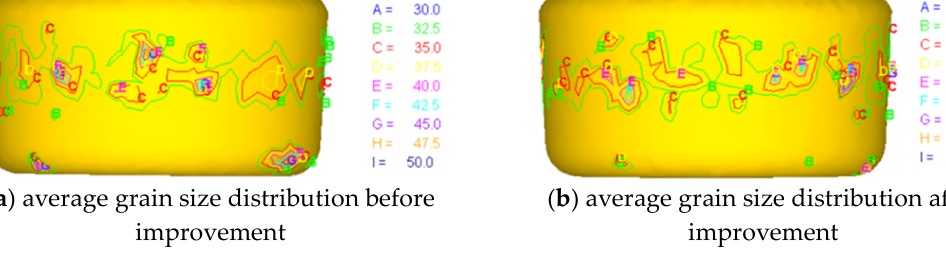
Figure 13. Comparison of grain refinement effect of the wheel hub.